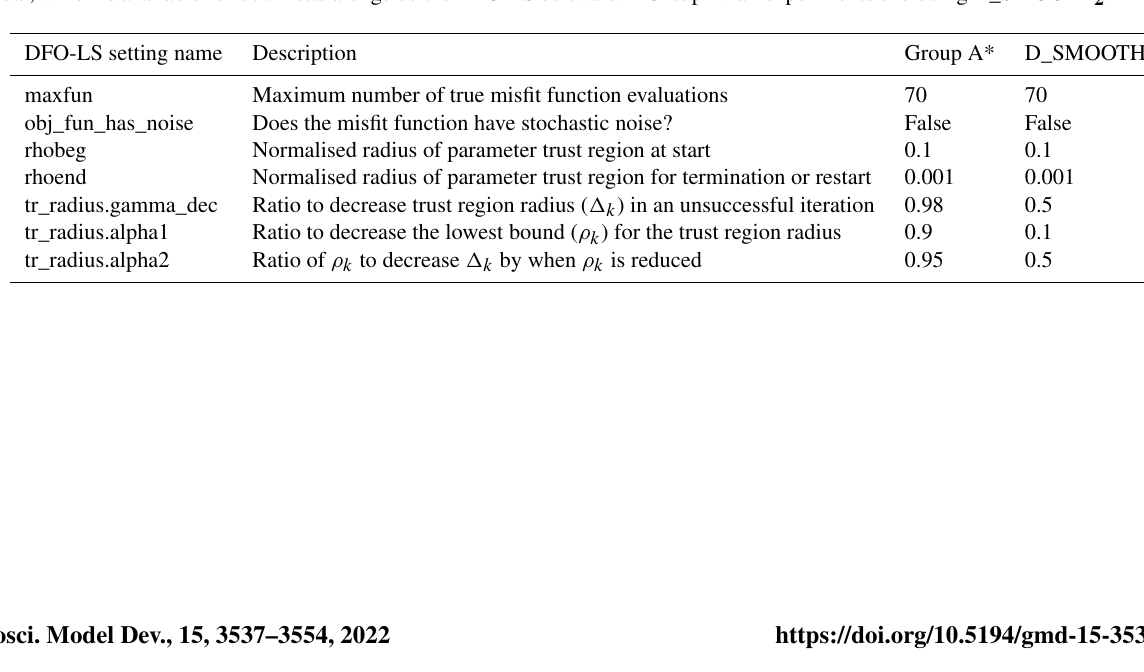
Table B1. DFO-LS parameter settings for each optimisation experiment. All parameter settings are described in full in the DFO-LS user manual, which is available for download alongside the DFO-LS software. * Group A: all experiments excluding D_SMOOTH 2